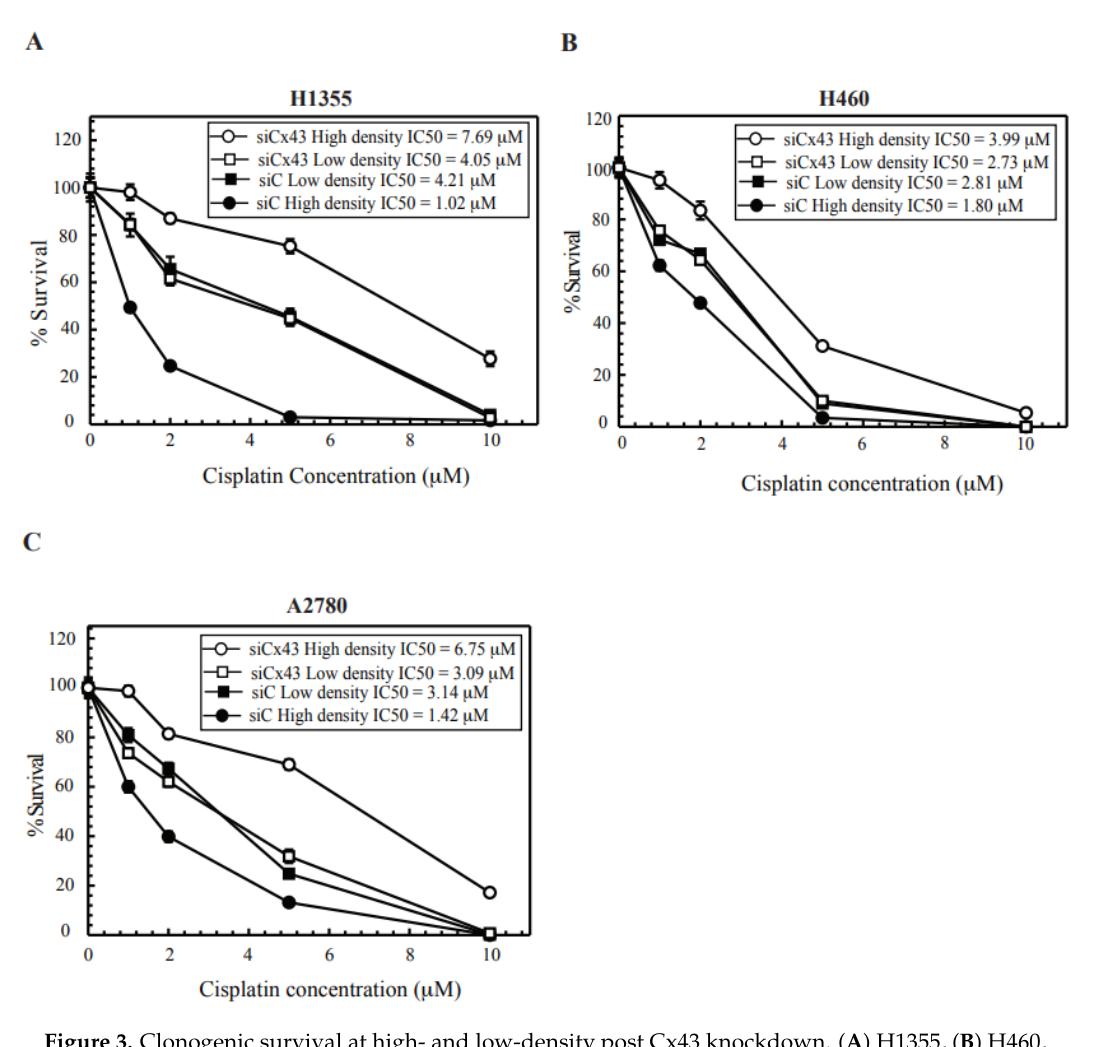
Figure 3. Clonogenic survival at high- and low-density post Cx43 knockdown. ( A ) H1355, ( B ) H460, ( C ) A2780 cells. Non-targeting siRNA transfected (siC) and siCx43 transfected cells were treated to cisplatin at high density and low density and plated for colony survival as described in the methods section. Calculated IC 50 values are represented in each figure for each cell line. Values are represented as mean ± SEM from three independent experiments, each plated in triplicate.